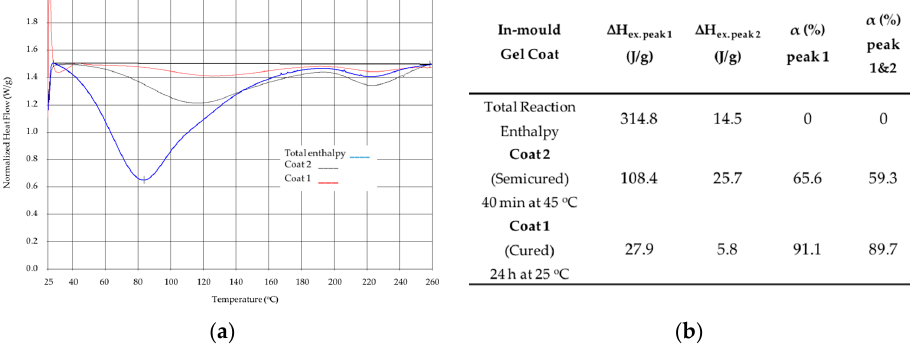
Figure 15. ( a ) DSC measures reaction enthalpy; ( b ) degree of curing conversion ( α ) measured data.